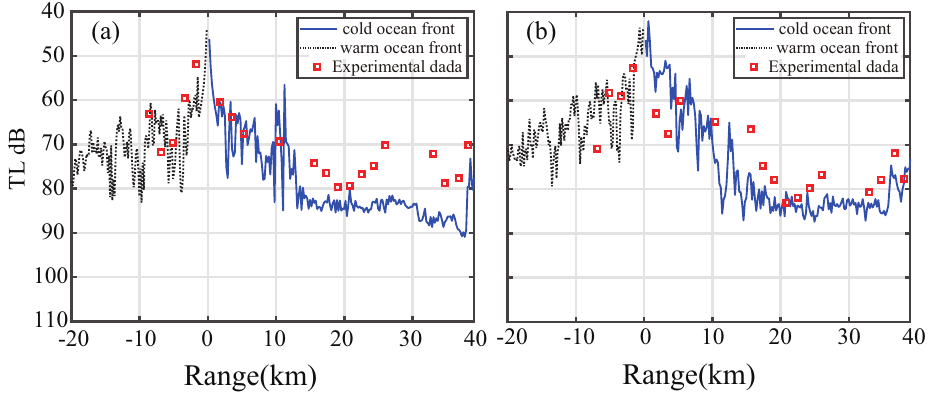
Figure 17. 2-D Transmission Loss in cold side (blue line), warm side (black dotted line) and experi- mental results with 200 m explosions (red square) in depths of 175 m ( a ) and 200 m ( b ).